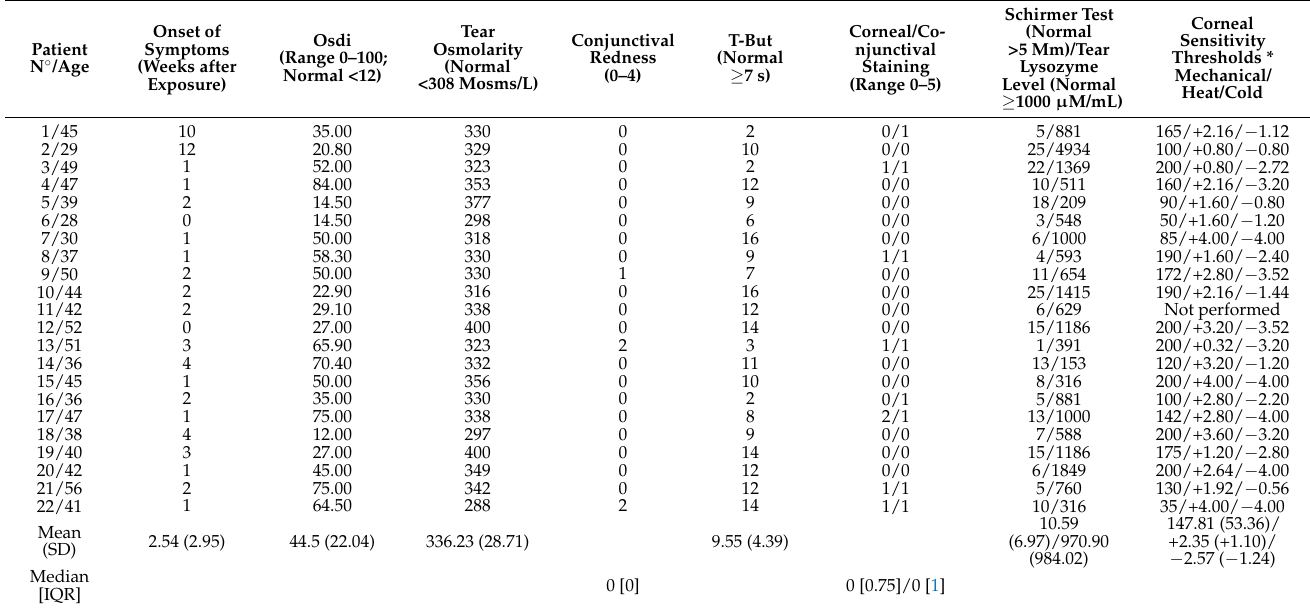
Table 1. Clinical tests results for mercury-intoxicated male patients.